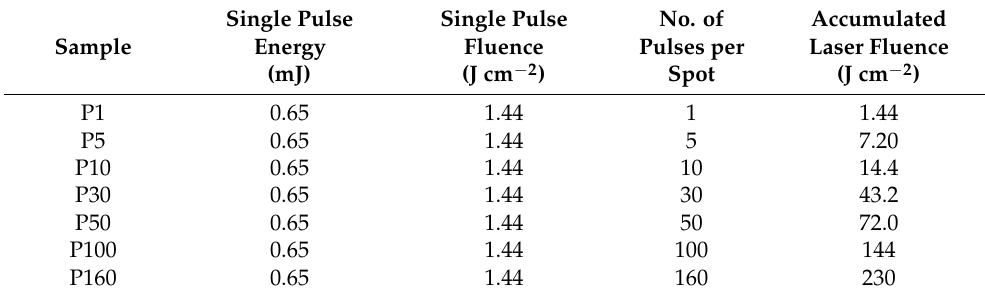
Table 1. Experimental parameters of the seven different laser irradiation treatments.